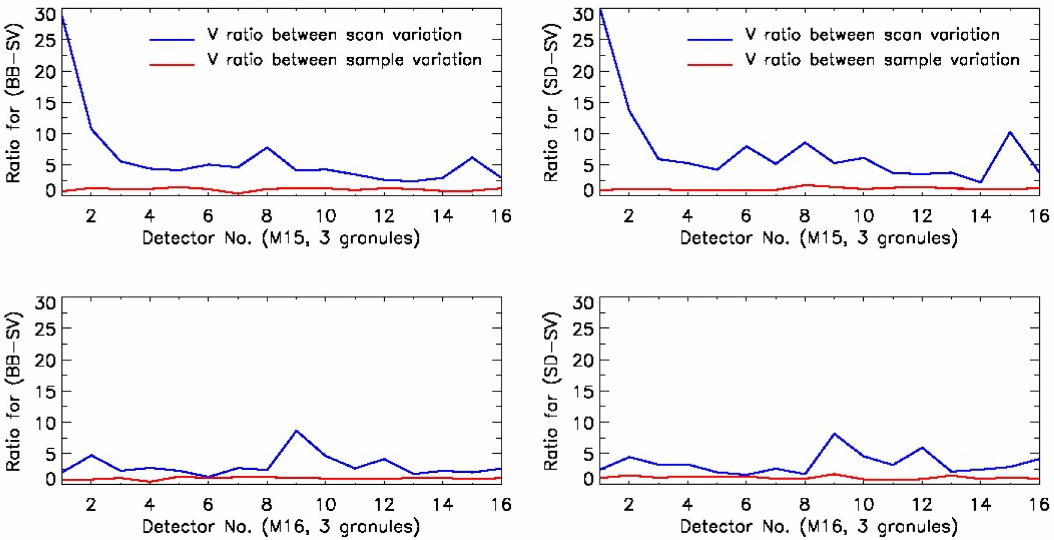
Figure 12. Two way Analysis of Variance (ANOVA) test ratio versus 16 detectors for dBB ratio ( left panels ) and dSD ratio ( right panels ) along tracks and along scans in M15 ( top panels ) and M16 ( bottom panels